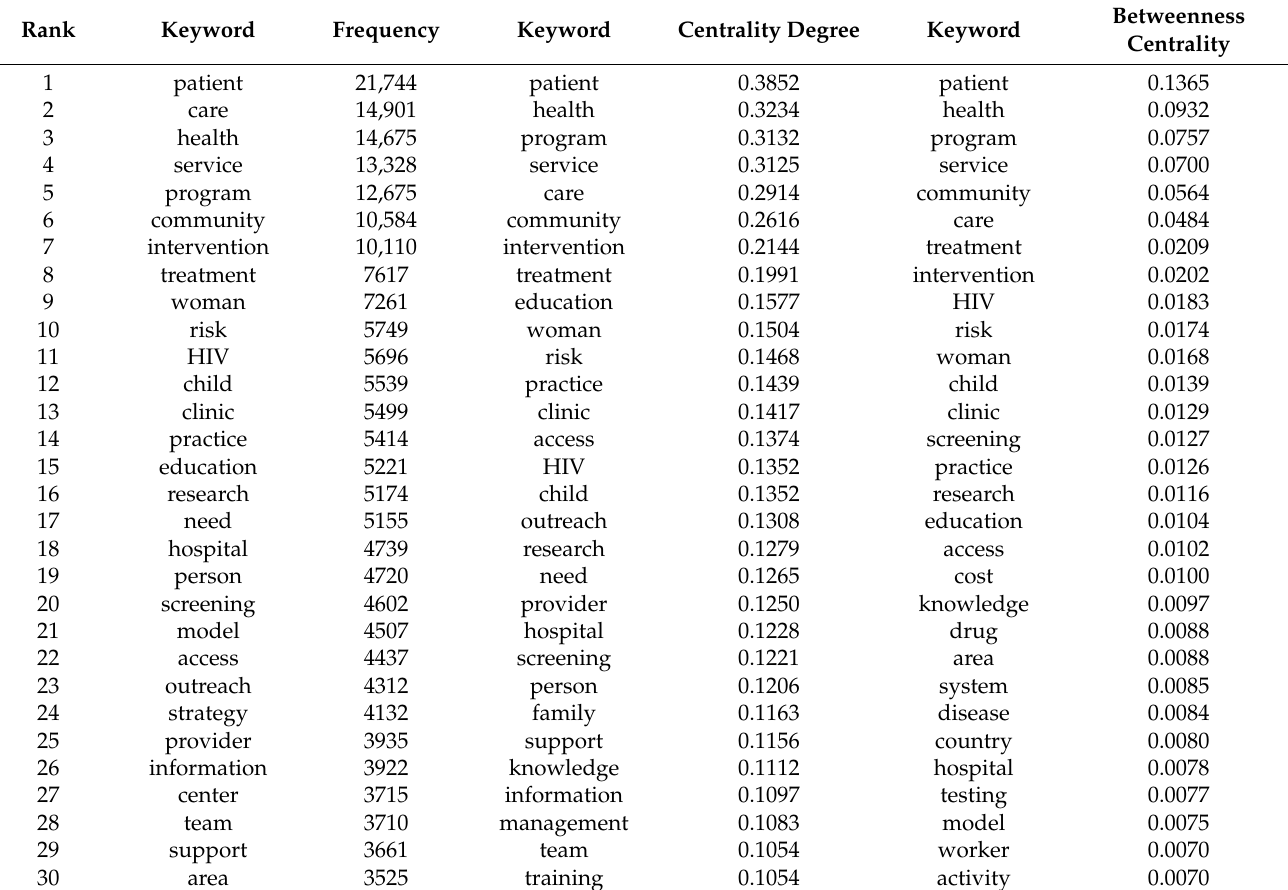
Table 1. Top 30 keywords that emerged from the outreach